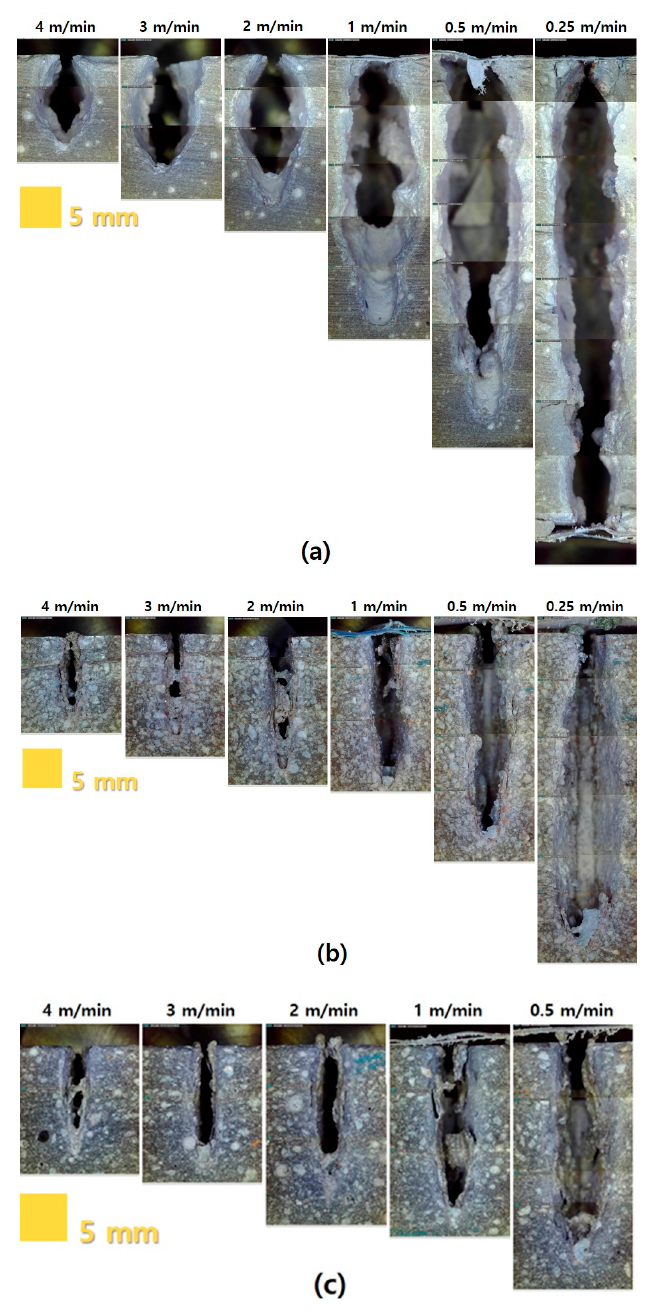
Figure 7. Penetration depth of ( a ) LP 0.25, ( b ) LM 0.25, and ( c ) LU- Ⅰ .